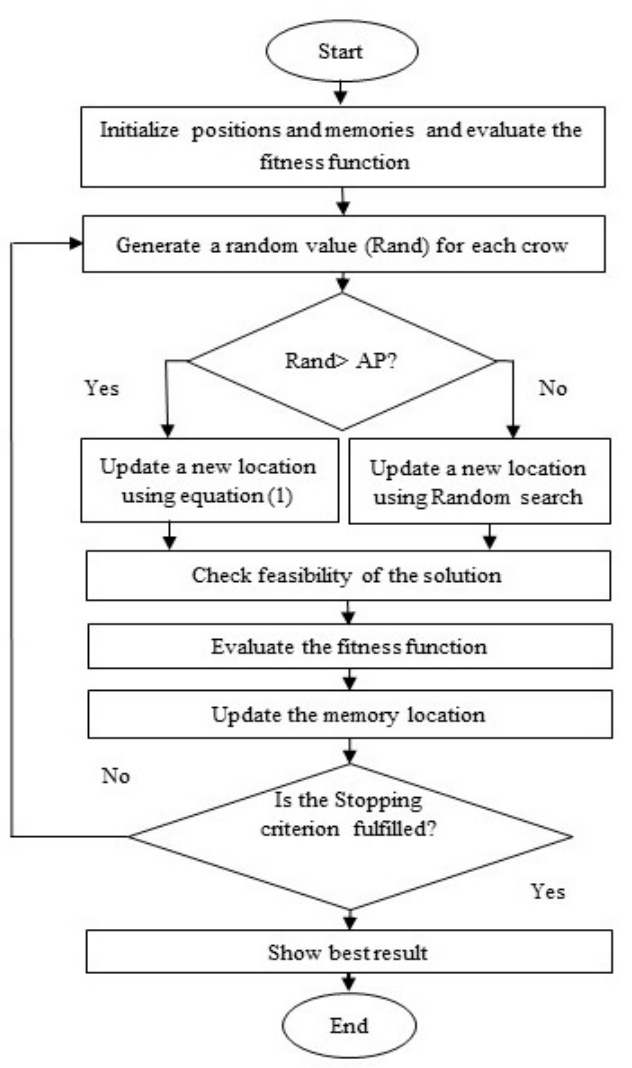
Figure 3. Crow Search Algorithm (CSA) algorithm flow chart.